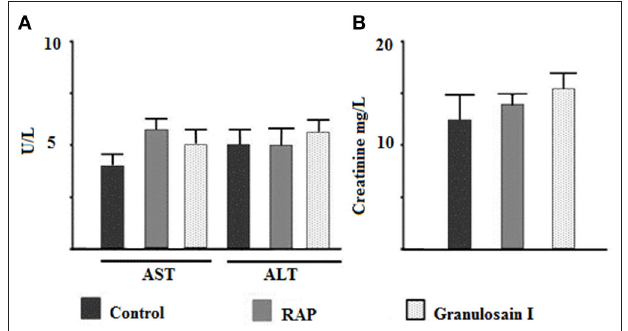
FIGURE 4 | Citotoxicity assays. Effect of the partially purified proteolytic extract (RAP) of the fruits of Solanum granuloso leprosum and the main purified fraction (granulosain I) on: (A) The activity of aspartate aminotransferase (AST) and alanine aminotransferase (ALT), and (B) Creatinine in serum. Results represent the Mean ± SD of three independent experiments. PBS was administered to the control